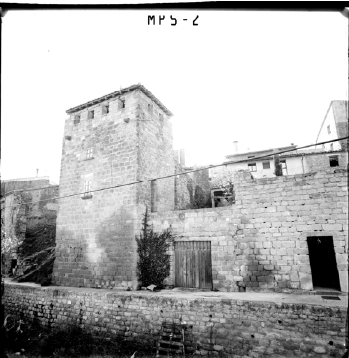
Figure 9. Wireframe model of the graveyard, drawn in the year 2000 by means of photogrammetric stereoplotting.